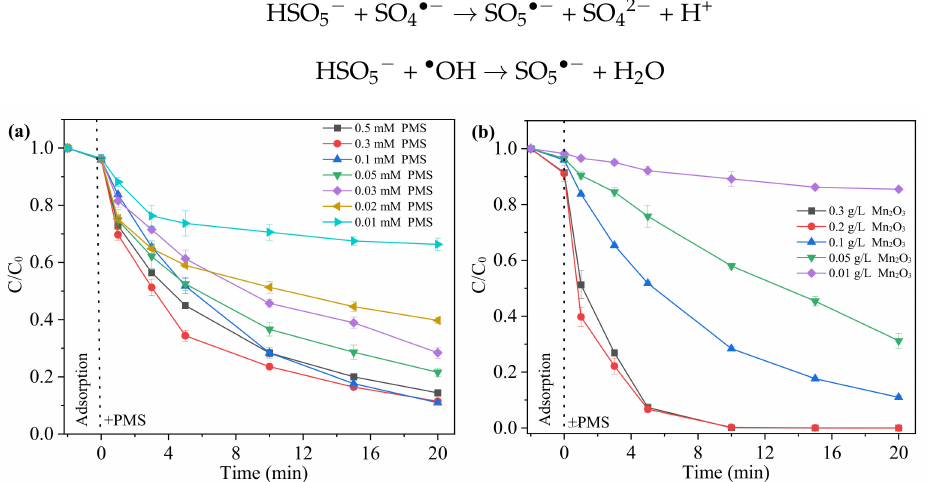
Figure 2. Effects of ( a ) PMS concentration and ( b ) Mn 2 O 3 dosage on the degradation of BPA. ( a ) Reaction conditions: [BPA] 0 = 10 mg/L, [PMS] 0 = 0.01–0.5 mM, [Mn 2 O 3 ] 0 = 0.1 g/L, initial pH = 7.0; ( b ) Reaction conditions: [BPA] 0 = 10 mg/L, [PMS] 0 = 0.1 mM, [Mn 2 O 3 ] 0 = 0.01–0.3 g/L, initial pH = 7.0 ±